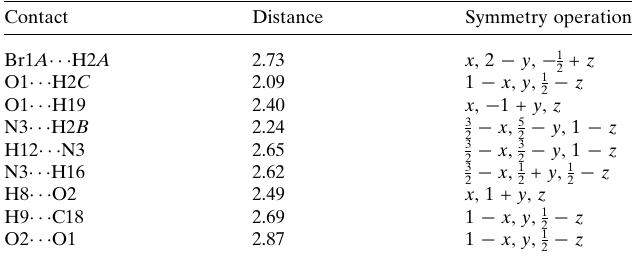
Table 3 Summary of short interatomic contacts (A˚ ) in compound